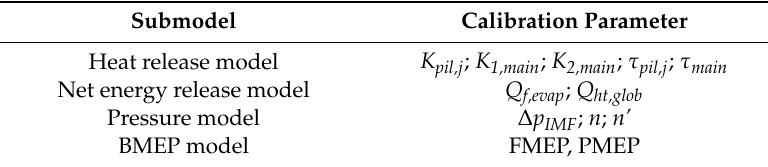
Table 2. Tuning parameters of the physics-based